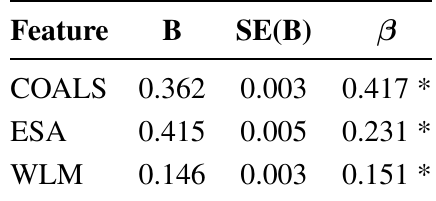
Table 9. Regression of COALS, ESA, and WLM raw scores on MCSM similarity scores (N =